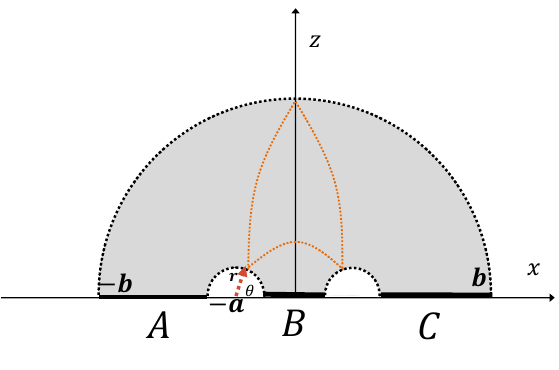
Figure 7 . The computation of (cid:1) W in pure AdS 3